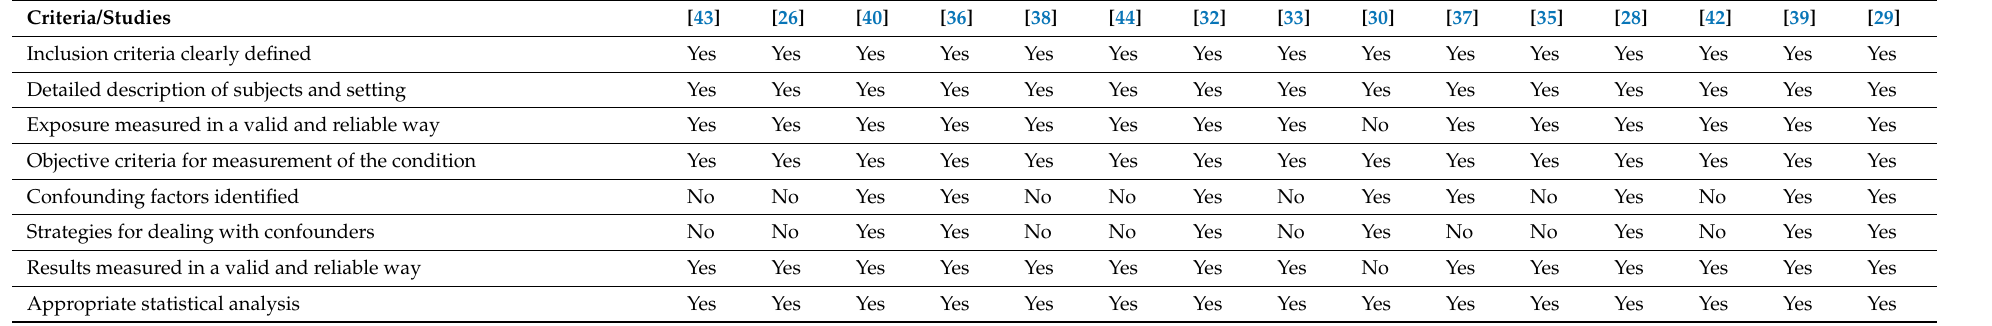
Table 2. Critical appraisal of the included studies—Analytical cross-sectional studies.